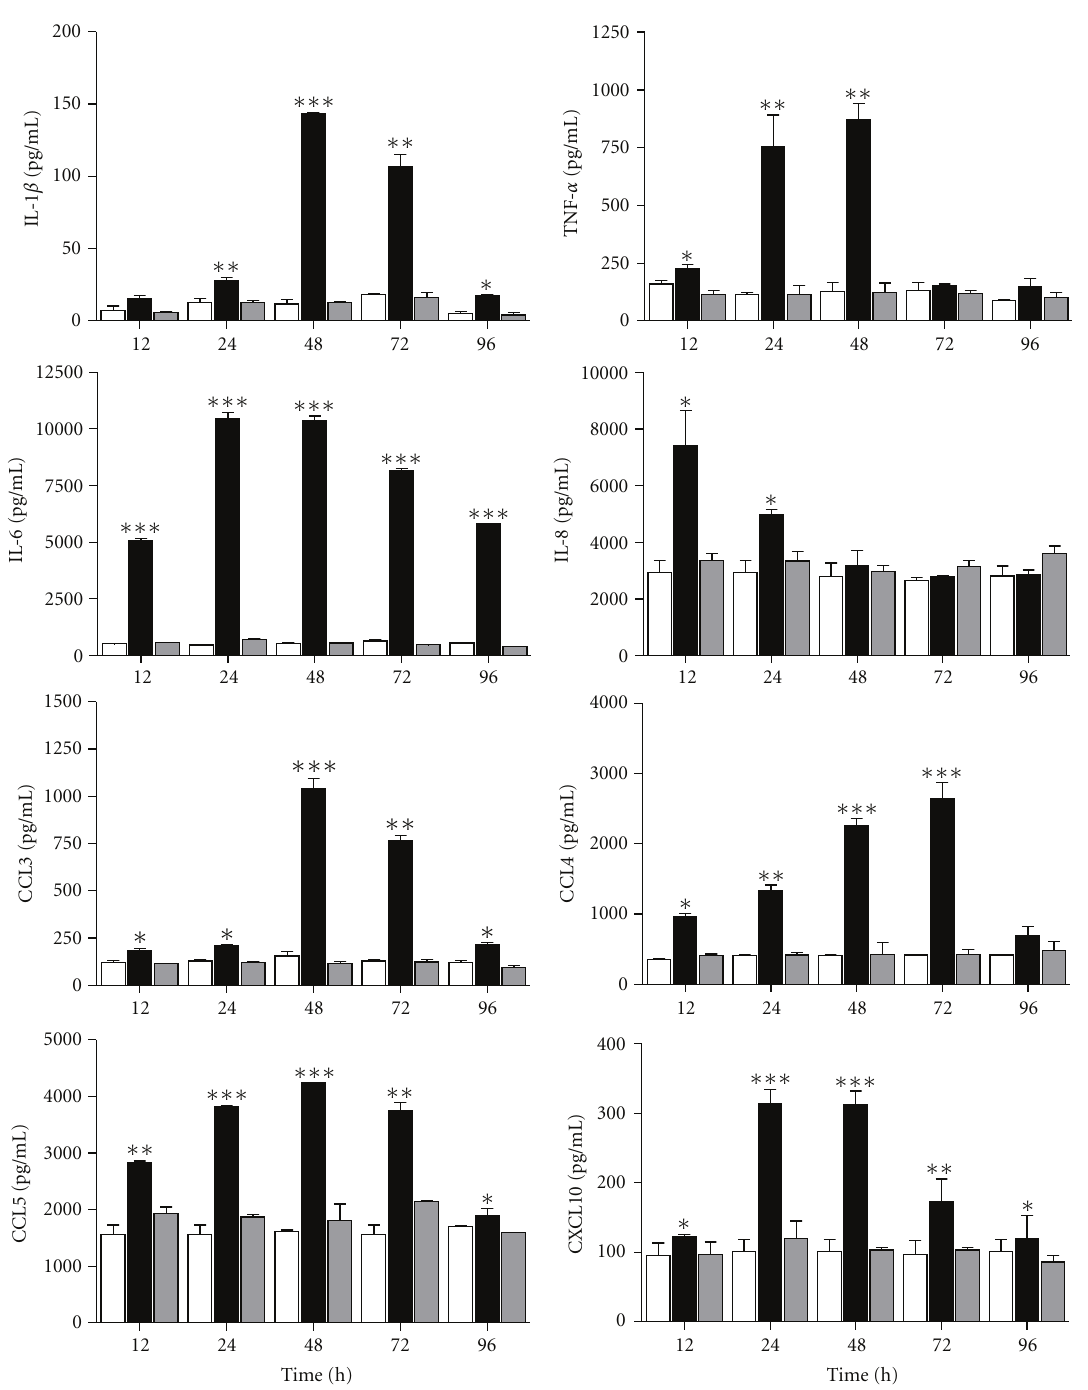
Figure 3: Profile of cytokines and chemokines induced by rMBP::SSP4 in PBMC. PBMC was stimulated with the protein for 12–96 h, and cytokines and chemokines were measured in cells’ culture supernatants by ELISA. Unstimulated cells (open bars), cells stimulated with rMBP::SSP4 (full bars), and cells stimulated with MBP (gray bars). Histograms show values in pg/mL (means ± SD) of three experiments run in duplicate. ∗ , ∗∗ , ∗∗∗ P < 0 . 05, 0 . 001, and 0 . 0001, respectively, versus unstimulated